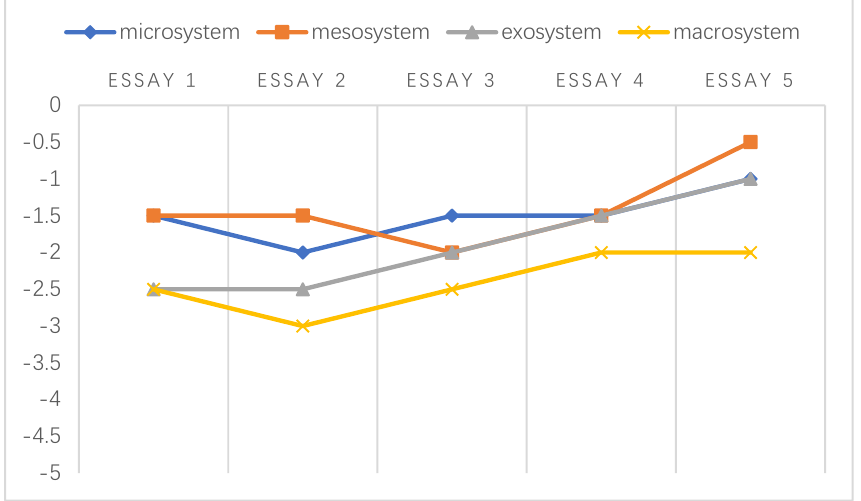
Figure 3. An illustration of T2’s emotional changes in the ecological systems after grading five essays. T2’s negative emotional trajectory exhibited a uniform distribution in all systems. It seemed that T2’s ability to cope with emotional discomfort was relatively high; in other words, his emotional capacity helped him adapt to challenging situations. As shown in Figure 3, T2 exhibited encouraging emotional development in the exosystem since he found an effective way to overcome adversity and prevent himself from limiting his beliefs, as described in Extract 14. clearly, and she supported my insistence on academic ethics (T2, journal 3).